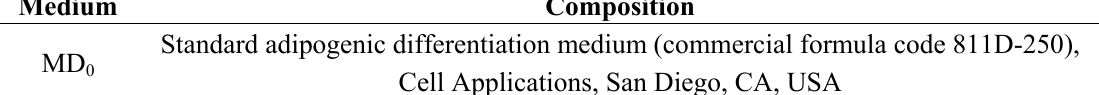
Table 1. Adipogenic media composition of P induced adipogenesis.